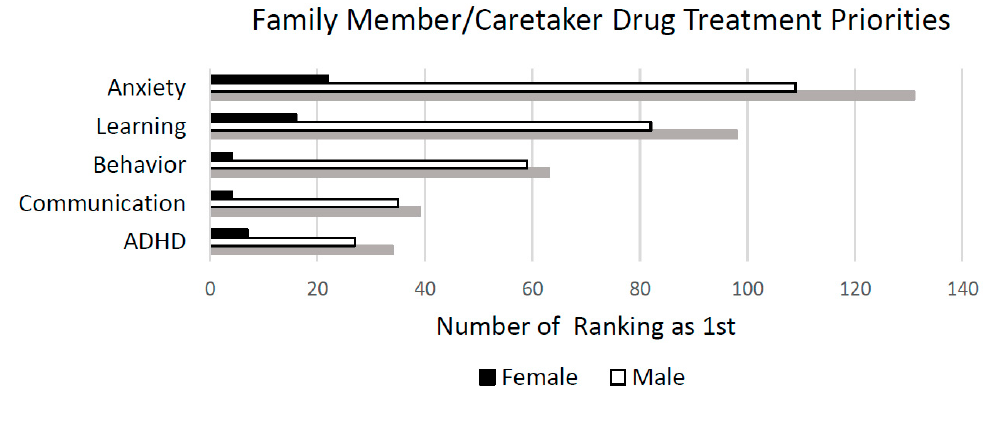
A Figure 4. Cont